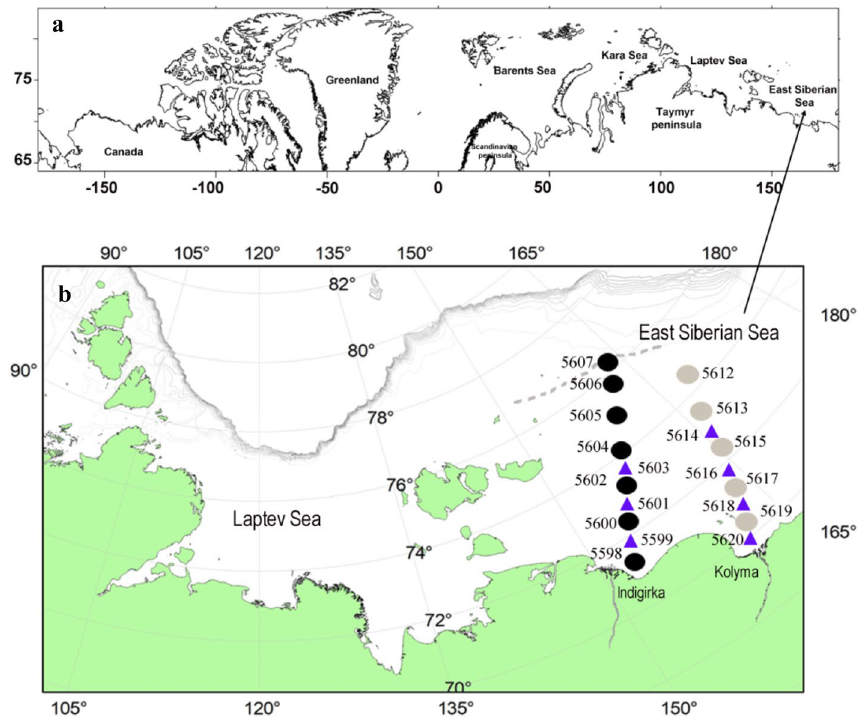
Figure 8. Location of East Siberian Sea ( a ) and map with station positions in the East Siberian Sea ( b ). Map was created with Golden Software Surfer version 8. Black circles indicate stations in Indigirka river, grey circles in Kolyma river. Blue triangles indicate additional hydrochemical stations without meiobenthic sampling. Ice extend during AMK 69 shown by grey dotted